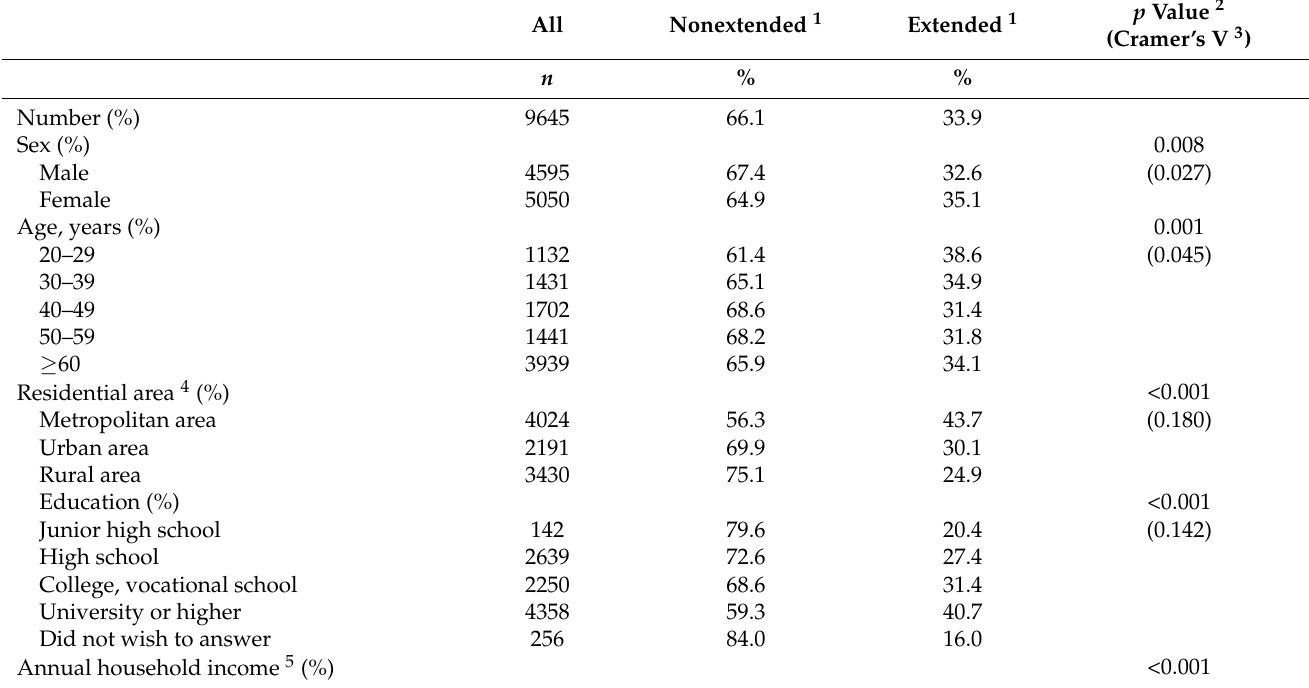
Table 1. Characteristics of participants according to changes in at-home hours during stay-at-home request